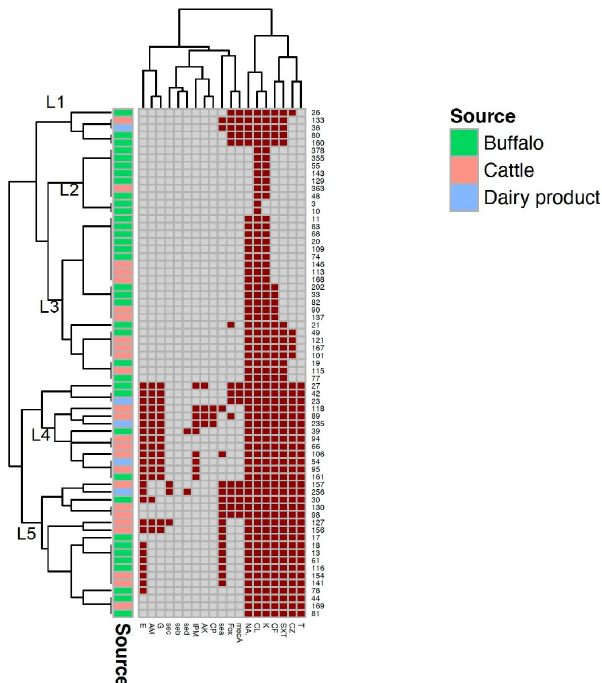
Figure 1. A heatmap showing the distribution of the antimicrobial resistance phenotypes, mec A and enterotoxin genes among the examined Staphylococcus aureus isolates from cattle, buffalo, and dairy products. Dark red squares indicate phenotypic resistance, the presence of mec A and enterotoxin genes; grey squares indicate phenotypic susceptibility and absent genes. Five clusters (L1 – L5) are indicated in the figure.